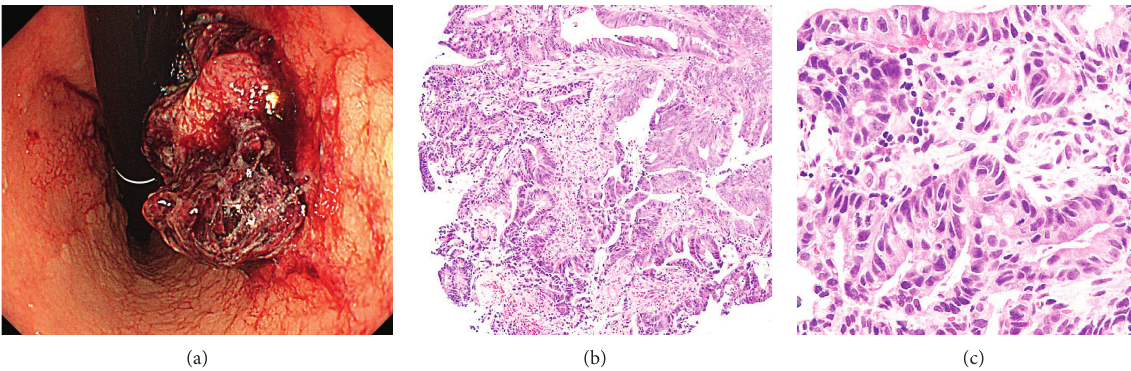
Figure 1: (a) Upper gastrointestinal endoscopy findings. A type 1 tumor with a diameter of 30mm is found on the posterior wall of the gastric body. The tumor is easily bleeding. (b) Histopathologic findings of the biopsy specimens of gastric cancer. Findings of well- differentiated adenocarcinoma. Hematoxylin and eosin staining, × 100. (c) Hematoxylin and eosin staining, × 400.